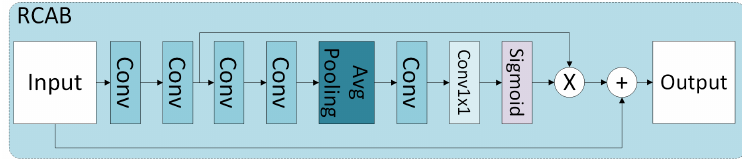
Figure 5. Architecture of the RCAB.